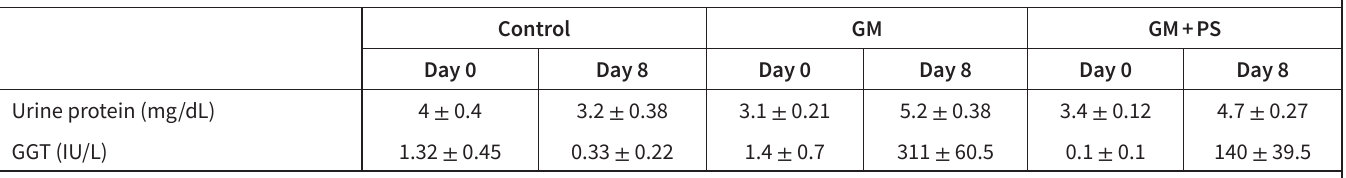
Table 2. The Urine Protein (mg/dL) and GGT (IU/L) Results of the Groups on Day 0 and Day 8